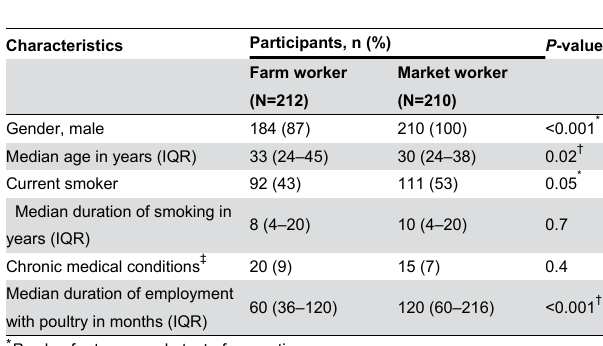
Table 1. Baseline characteristics of poultry workers,